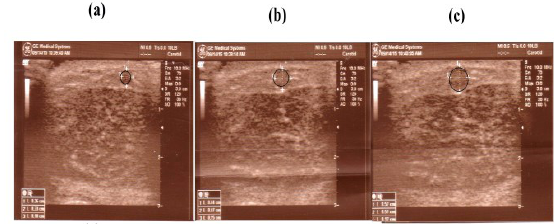
Fig. 3 The vein cross-sectional changes: a) The vein before occlusion. b) The vein after 30 sec of occlusion. c) The vein after 1 minute of